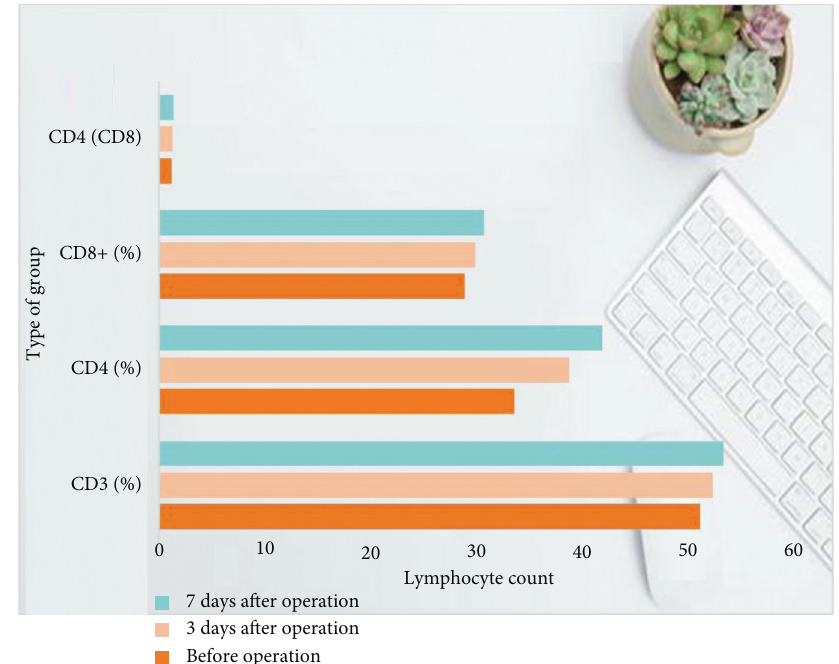
Figure 2: The changes of T lymphocyte before and after bone graft.